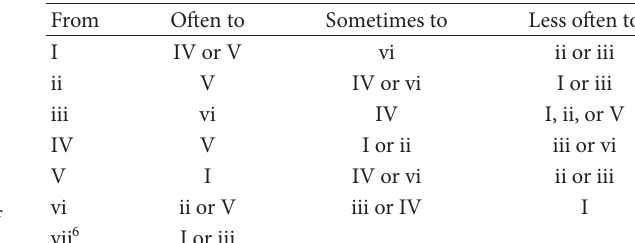
Table 1: The table summarizes the most used root progressions in tonal harmony [27]. Note that the vii-degree chord is not rep- resented in root position, but in its first inversion, as it appears most of the